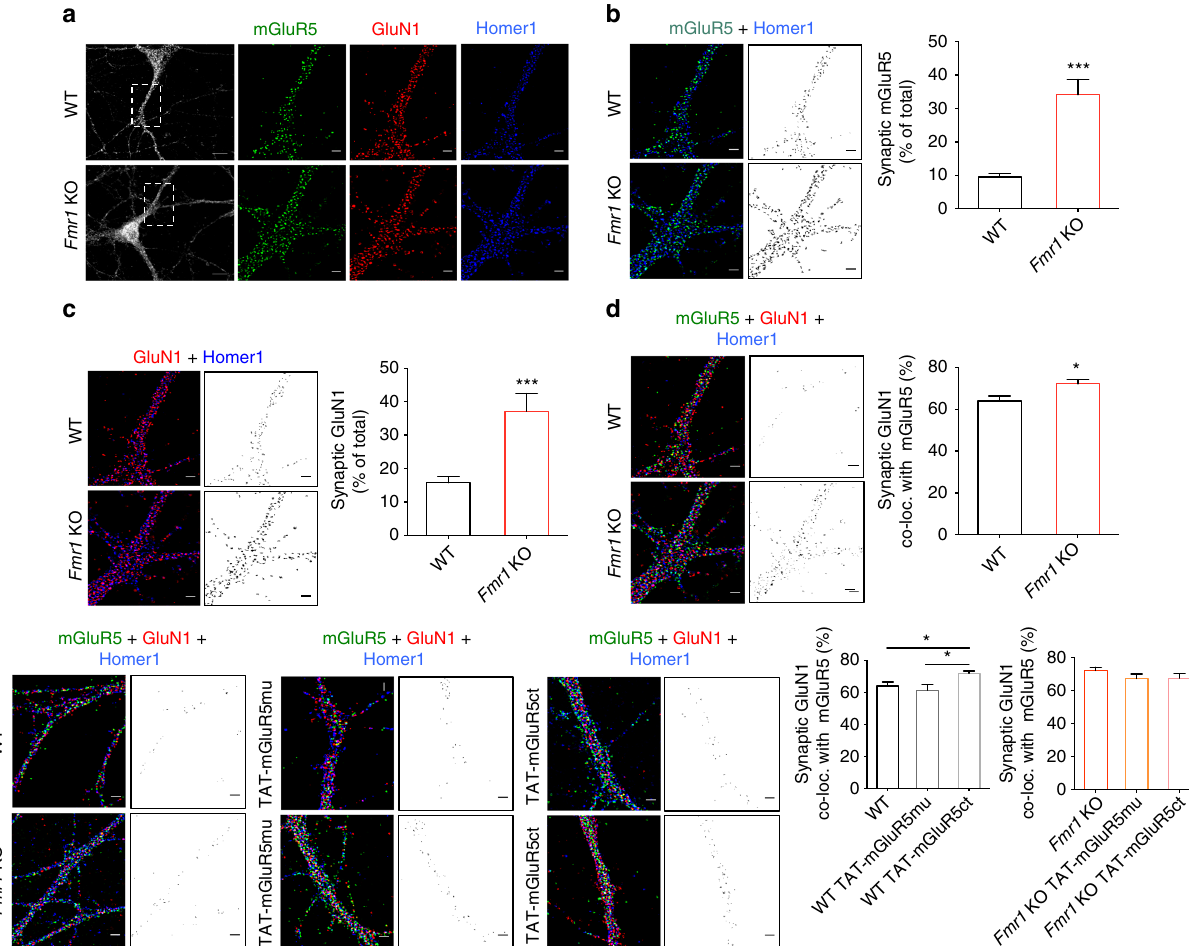
Fig. 4 Disruption of the mGluR5/Homer scaffold increases surface mGluR5/NMDAR co-clustering. ( a ) Cultured WT and Fmr1 KO hippocampal neurons were triple-labeled for mGluR5, GluN1 and Homer1. ( b , c ) Left: Representative image of Homer/mGluR5 and Homer/GluN1 co-localization; middle: Distribution of co-localized mGluR5/Homer1 or GluN-/Homer1 clusters; right: mGluR5/Homer1 and GluN1/Homer1 clusters as percentage of total mGluR5 or GluN1 signal (mGluR5: WT, 9.53 ± 0.959 %, n = 27; Fmr1 KO, 34.14 ± 4.598 %, n = 20; ***P < 0.001, t = 6, df = 45, unpaired Student ’ s t -test; GluN1: WT 15.75 ± 1.841 %, n = 29; Fmr1 KO 37.15 ± 5.324 %, n = 18; ***P < 0.001, t = 4.47, df = 45, unpaired Student ’ s t -test). ( d ) Left: Representative image showing mGluR5/GluN1/Homer1 colocalization; middle: Distribution of co-localized mGluR5/GluN1/Homer1 labeling; right: Co-localized mGluR5/GluN1/Homer1 clusters as percentage of synaptic GluN1 signal (WT, 63.97 ± 2.414 %, n = 26; Fmr1 KO, 72.14 ± 2.081 %, n = 23; *P < 0.05, t = 2.53, df = 47, unpaired Student ’ s t -test). ( e ) TAT-mGluR5ct peptide increased mGluR5/GluN1 co-clustering at synapses in WT neurons, whereas TAT-mGluR5mu or TAT- mGluR5ct (both 5 µ M, 1 h) had no effect in Fmr1 KO neurons; Left: Representative images and distribution of mGluR5/GluN1/Homer1-co-labeling signal in control and TAT-mGluR5mu or TAT-mGluR5ct treated WT and Fmr1 KO neurons. Right: Co-localized mGluR5/GluN1/Homer1-positive signals as percentage of synaptic GluN1 signal (WT: 63.97 ± 2.414 %, n = 26; WT TAT-mGluR5mu: 61.19 ± 3.489 %, n = 14; WT TAT-mGluR5ct: 71.79 ± 1.528 %, n = 22; WT vs. WT TAT-mGluR5ct, *P = 0.043; WT TAT-mGluR5mu vs. WT TAT-mGluR5ct * P = 0.017, F (2, 59) = 4.87; Fmr1 KO: 72.14 ± 2.081 %, n = 23; Fmr1 KO TAT-mGluR5mu: 67.32 ± 2.832 %, n = 18; Fmr1 KO TAT-mGluR5ct: 67.58 ± 2.69 %, n = 26; Fmr1 KO vs. Fmr1 KO TAT-mGluR5ct P = 0.391; Fmr1 KO TAT-mGluR5mu vs. Fmr1 KO TAT-mGluR5ct P = 0.997, F (2, 64) = 1.13). P values by one-way ANOVA test with Tukey ’ s Multiple Comparison test. n = dendritic fi elds from 3 cultures. Scale bar = 10 μ m ( a ) 2 μ m ( b , c , d , e )